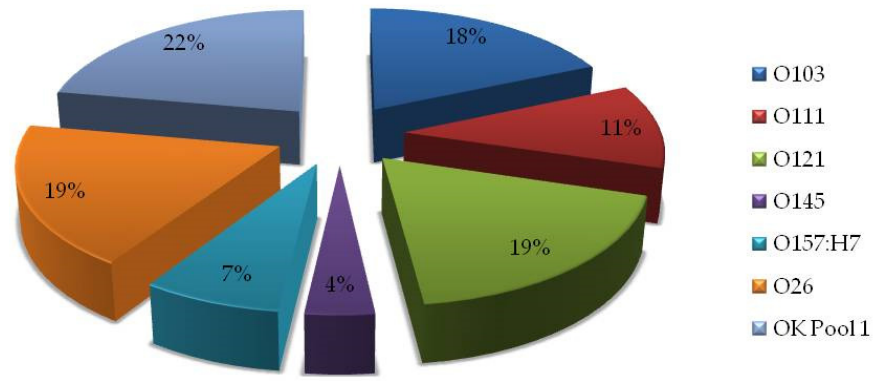
Figure 2. Frequency of serotypes of isolated STEC from feed in Croatia during the nine-year period ( n = 27 isolates). OK Pool 1: not fully typed, isolates gave positive agglutination with OK Pool 1, but not with individual antisera ( n =